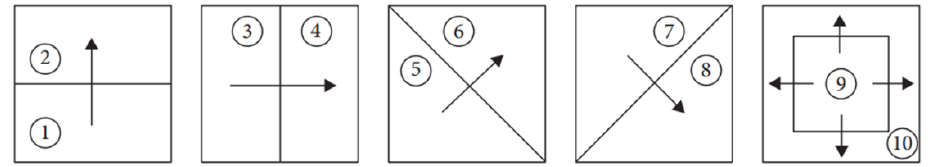
Figure 8. Details of the 10 areas divided when calculating the distribution uniformity. Table 1. Comparison of the uniformity and time consumption of two algorithms on the KITTI dataset sequence 00. Image